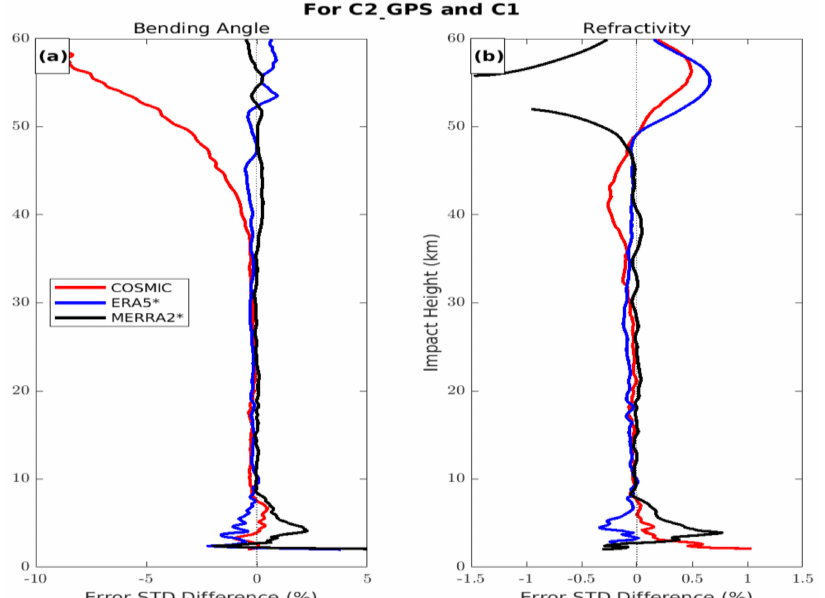
Figure 9. Differences in 3CH error STD estimates of ( a ) bending angle and ( b ) refractivity for C2 (GPS only) and C1 and the two reanalyses between August 2021 and August